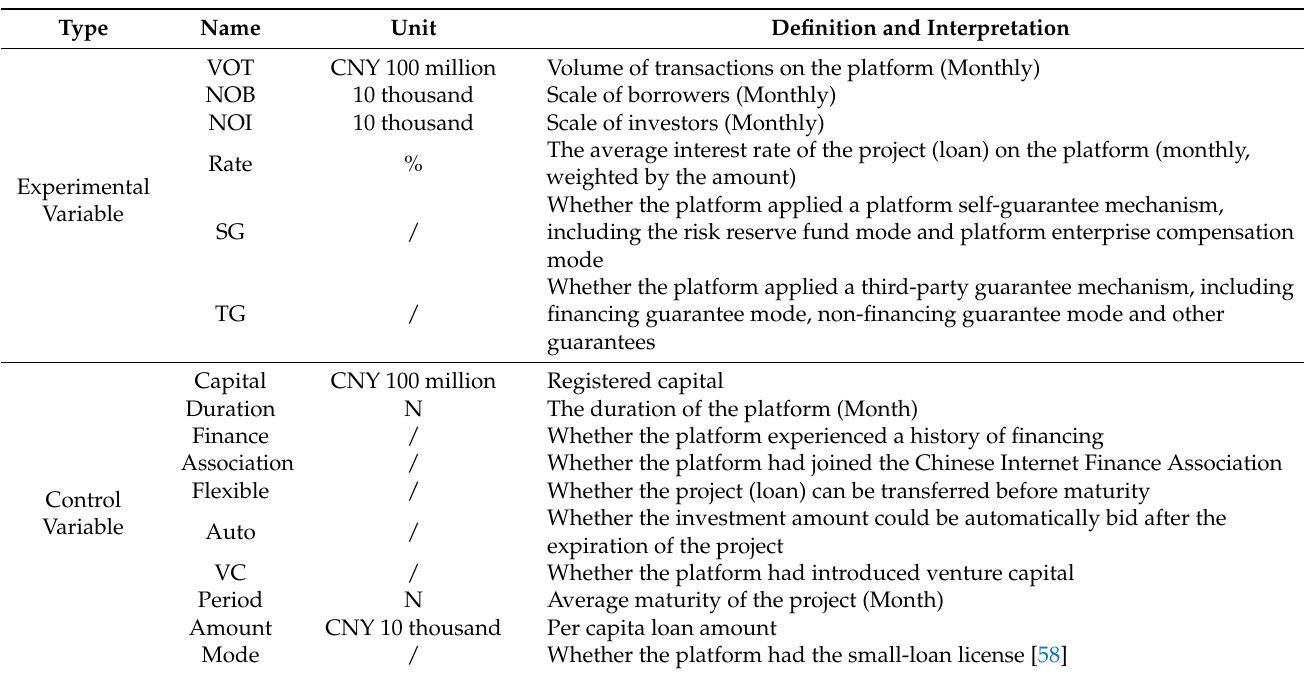
Table 4. Definition and interpretation of the variables in the empirical